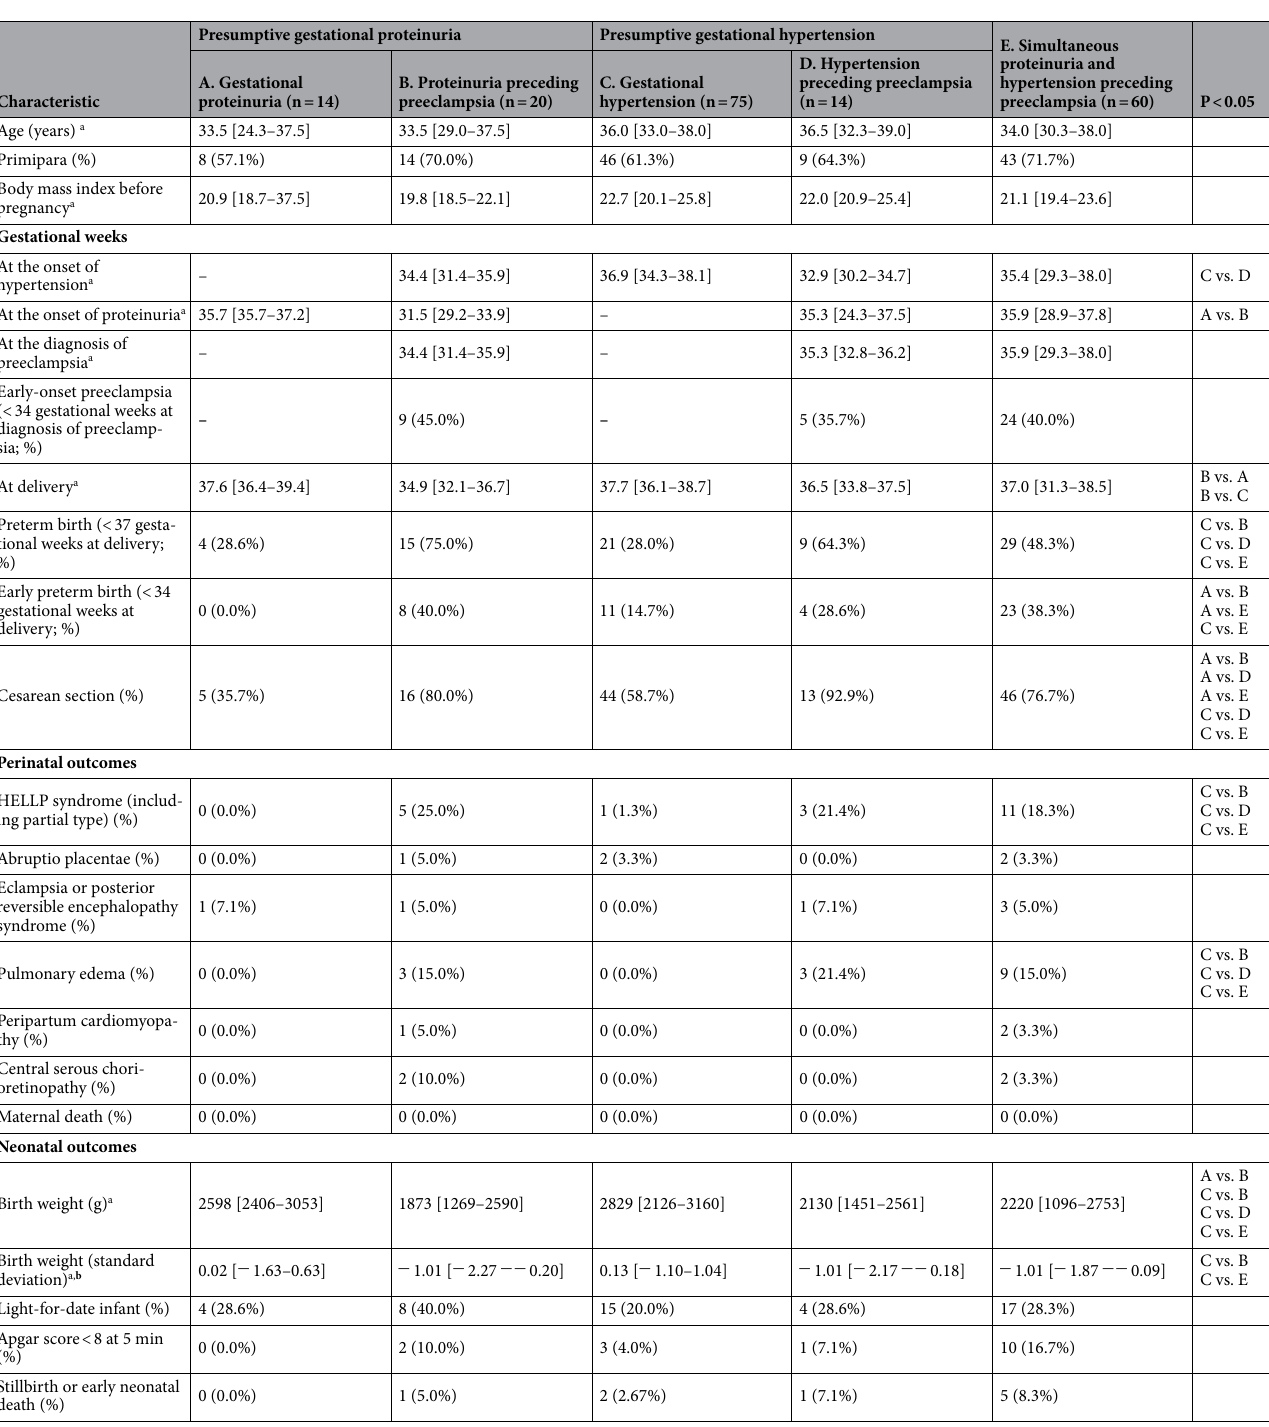
Table 1. Characteristics and outcomes of participants. a Data are listed as median (25th percentile–75th percentile). b Birth weight (standard deviation) are calculated according to normative data for Japanese infants 33 . HELLP hemolysis, elevated liver enzyme levels, and low platelet